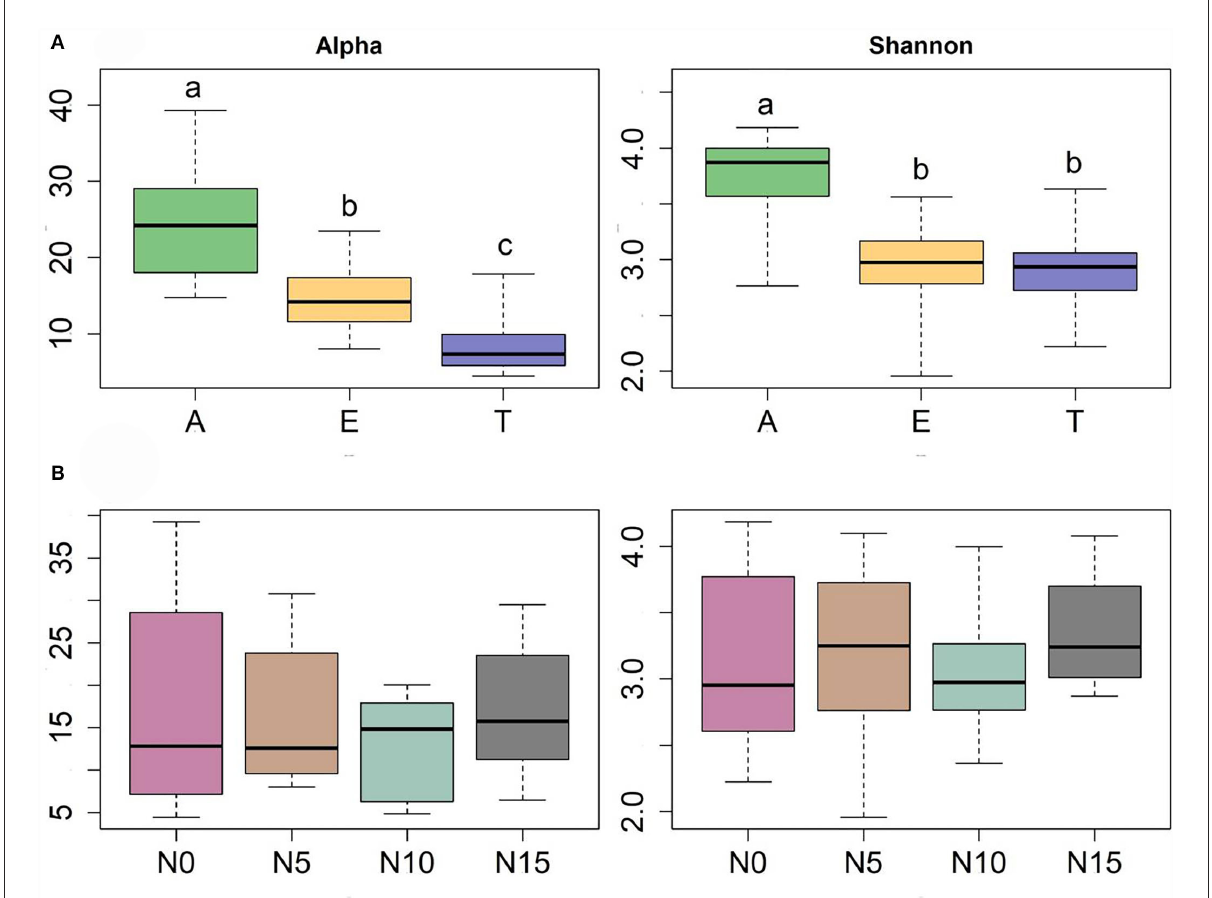
FIGURE2 Diversity patterns of the entire fungal community of three species against host (A) and N gradients (B) based on linear models. Alpha is the number of observed species, and Shannon is the Shannon diversity index. The sequences were rarified to 1,944, n = 71. Significant differences of each variable are indicated by dissimilar letters above boxes. A, Anemone rivularis ; E, Elymus nutans ; T, Thermopsis lanceolata . N0, N5, N10, and N15 referring to 0, 5, 10, and 15g N (NH 4 NO 3 ) m − 2 yr − 1 treatments, respectively.